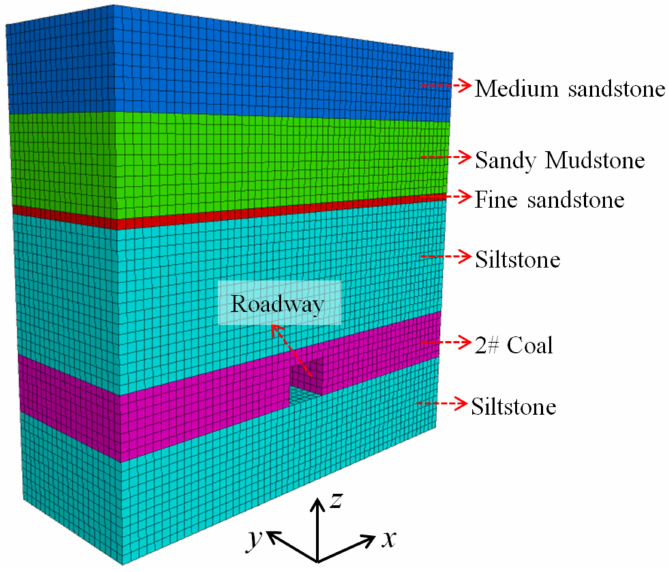
Figure 7. Numerical model establishment.